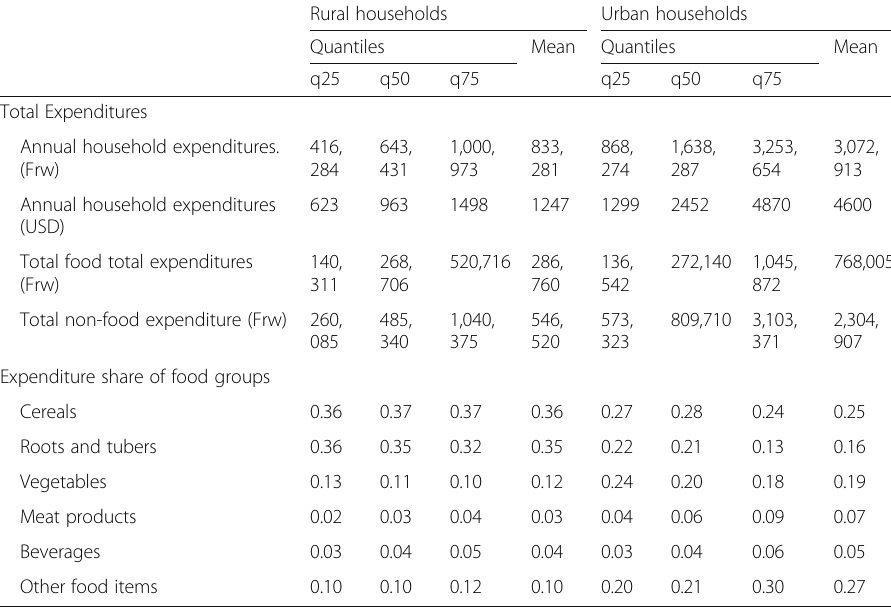
Table 2 Distribution of rural and urban household expenditures and of food group expenditure shares Rural households Urban households